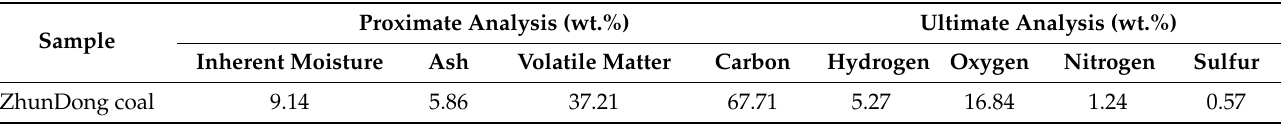
Table 1. Proximate and ultimate analysis of the Zhundong sample. Proximate Analysis (wt.%)